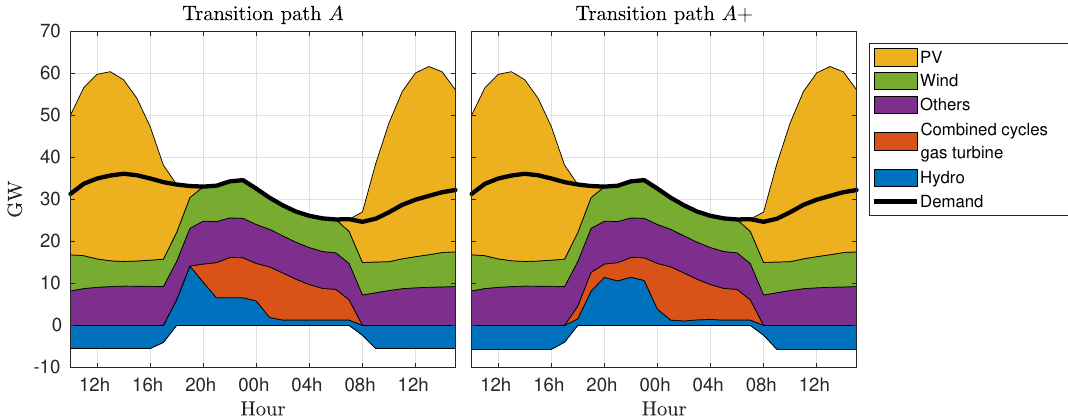
Figure 4. Power generation mix during a 24-h period in 2030 provided by the transition path analysis tool. Left : without considering the probabilistic model for hydropower generation (transition path A ). Right : including the probabilistic model (transition path A+ ).